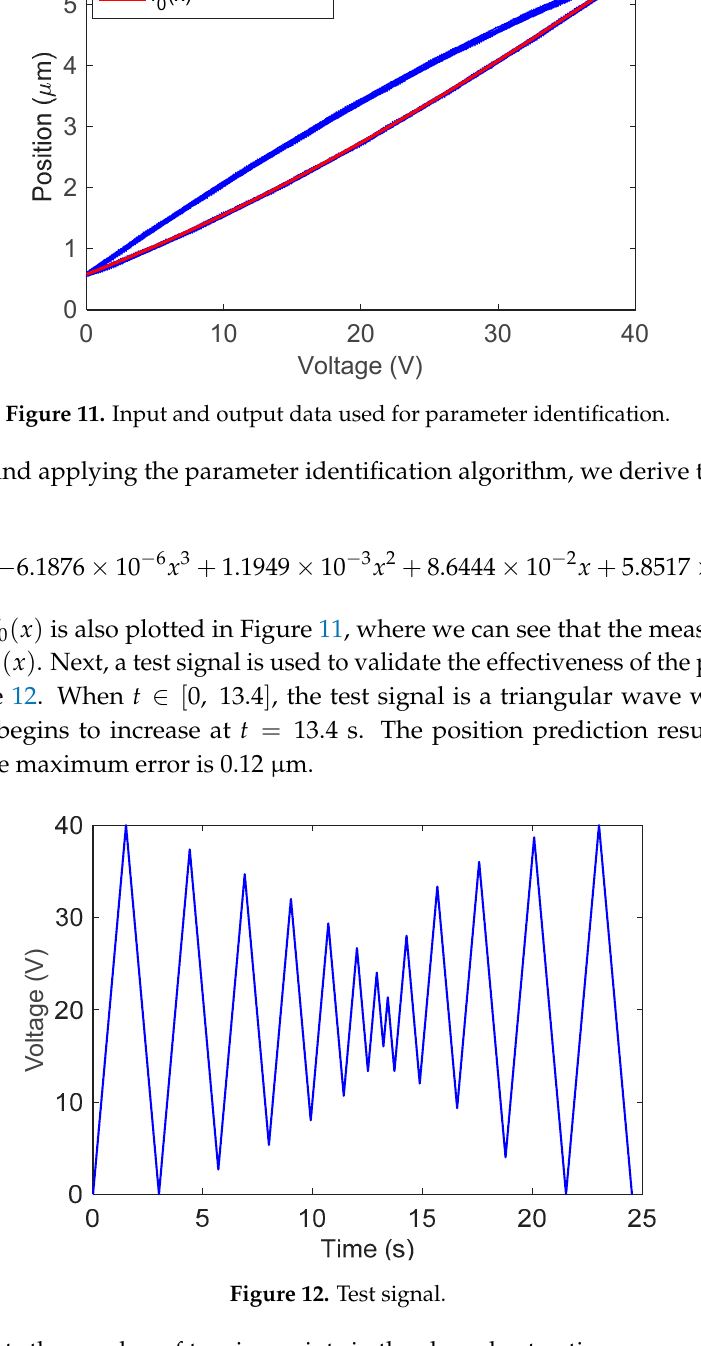
Figure 10. Triangular wave signal.